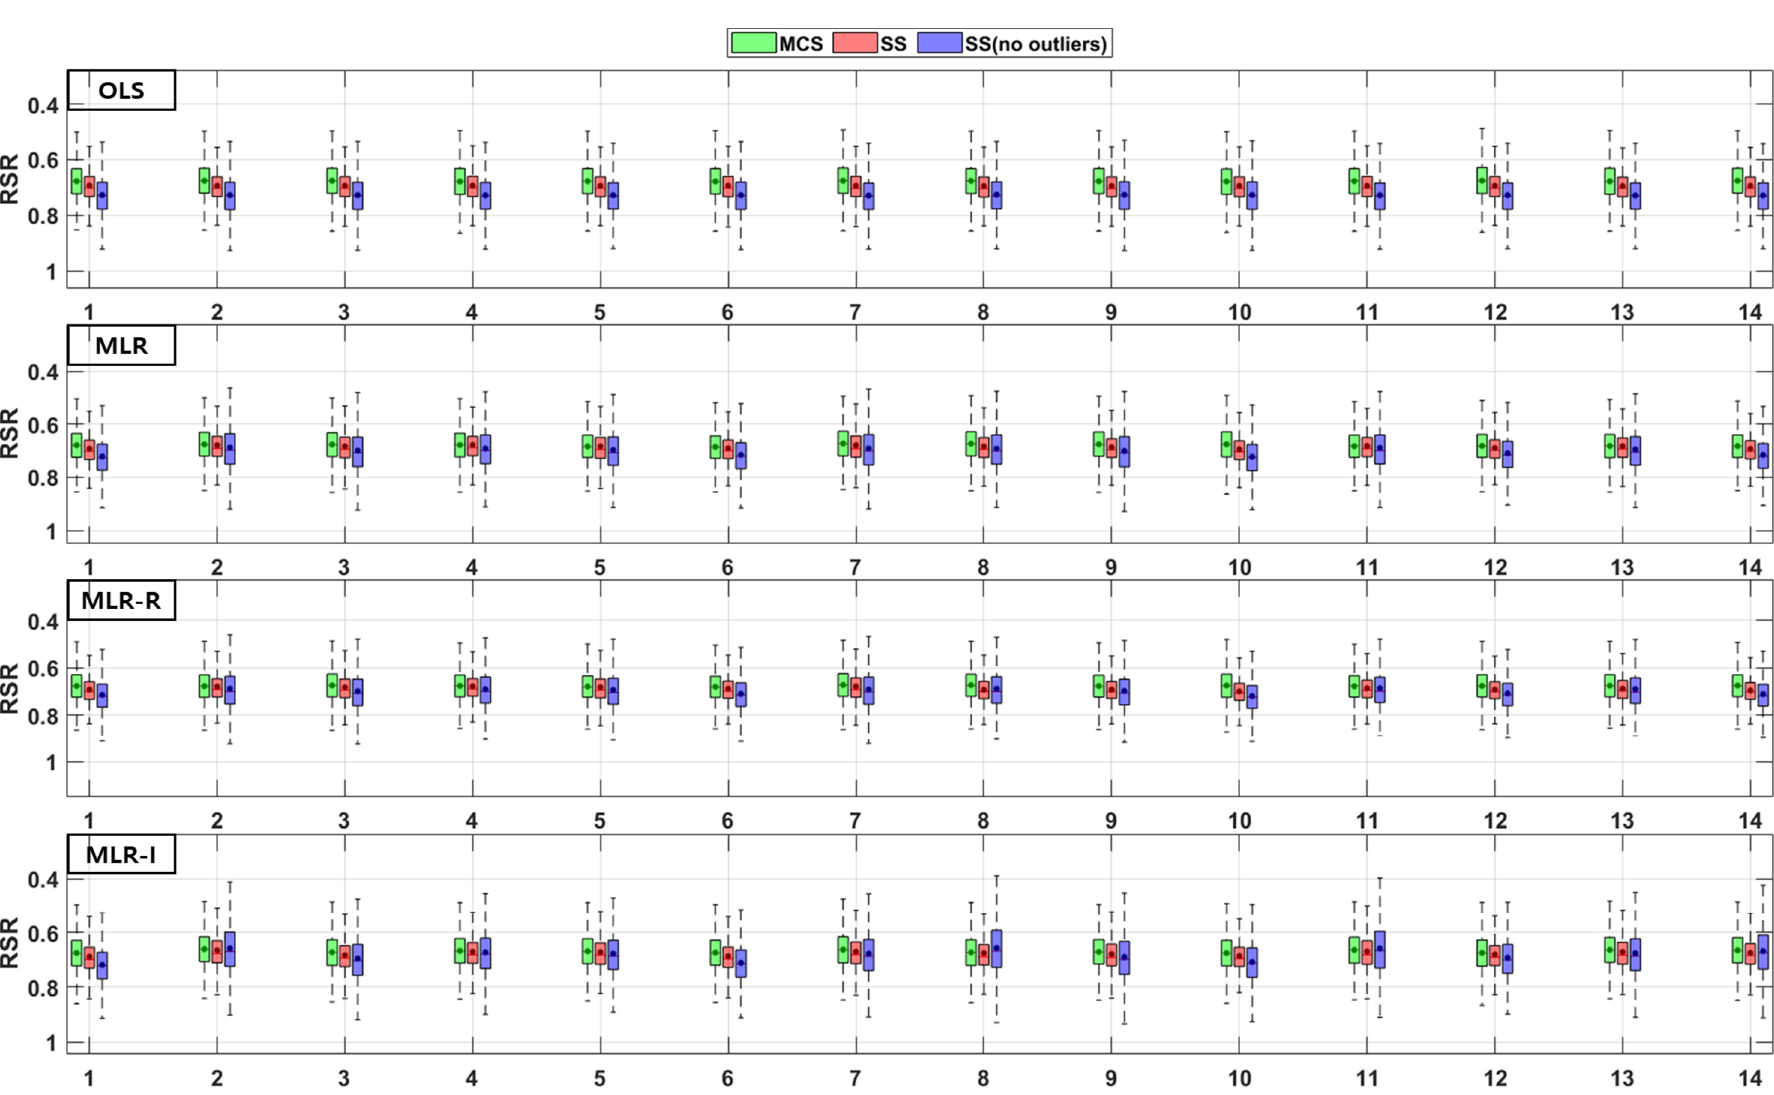
Figure 5. Error analysis (RSR) results of TSS removal in detention basins.